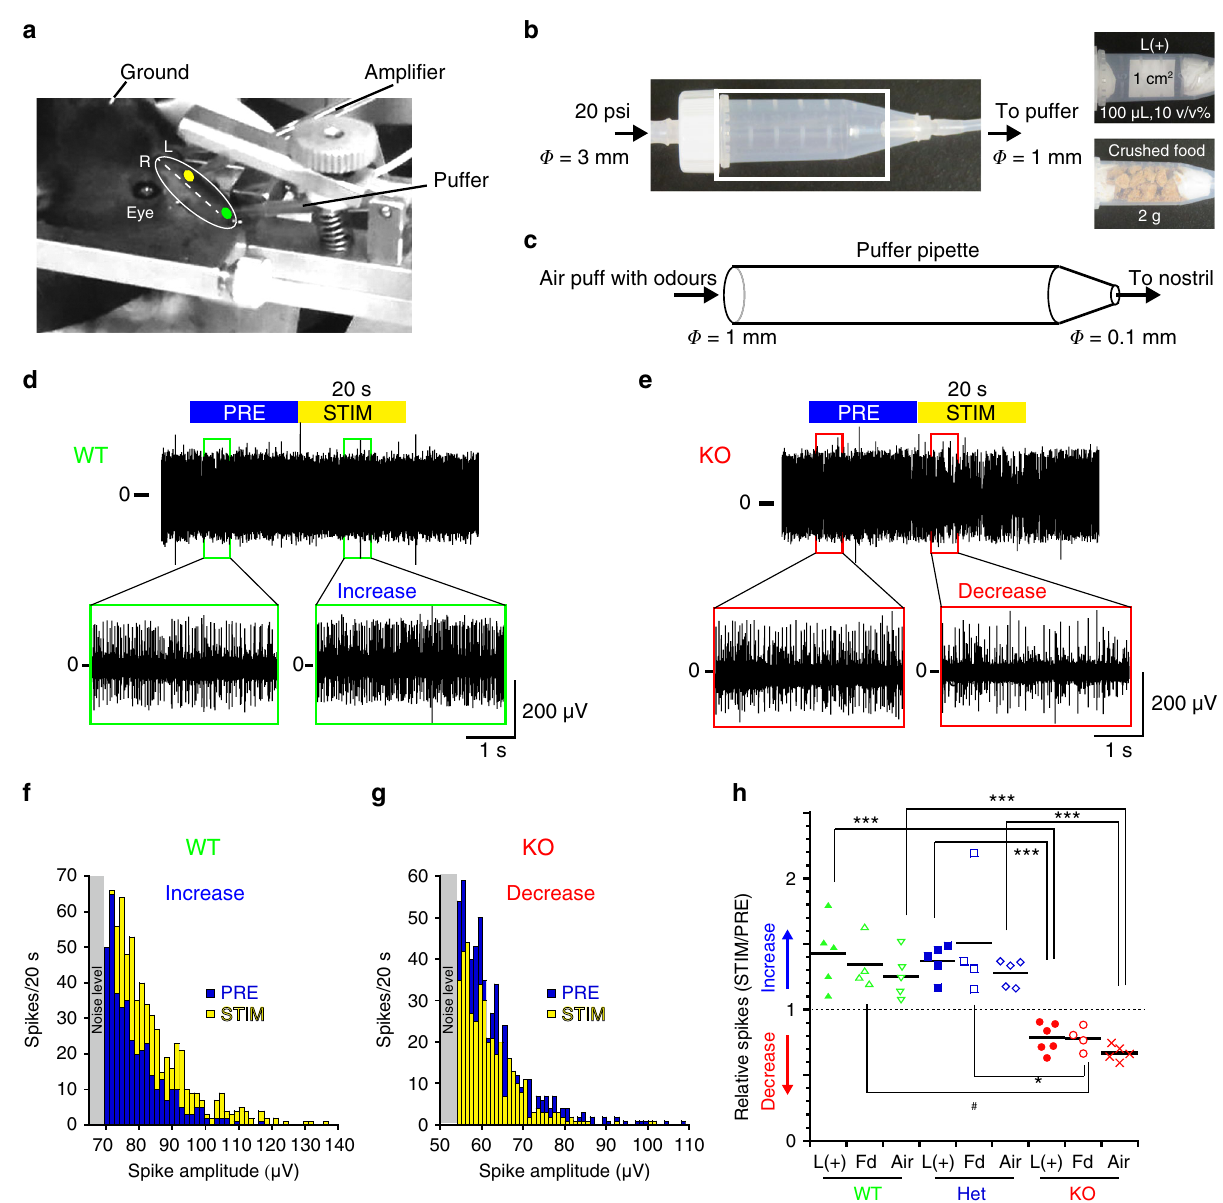
Fig. 7 OMP-KO nerves show rapid adaptation in response to repetitive stimulation. a Experimental setup of an in vivo multiunit recording from the nerve layer of the olfactory epithelium using a recording pipette inserted through a hole in the left nasal bone (a yellow dot). Odours were applied through a puffer pipette inserted into the left nostril (a green dot). b A 5-mL plastic tube containing scented fi lter paper or food as an odour application chamber was interconnected between a pressure pump and a puffer. c An approximately 0.2-psi air puff was applied from the puffer pipette into the nostril. Repetitive air puffs with 100-ms durations followed by 300-ms intervals at 20 psi were applied for 20 s. ϕ : diameters. d Multiunit responses from the nerve bundle layer of WT mice show sustained increases in fi ring during stimulation. e Multiunit responses from the nerve bundle layer of KO mice show a decrease during stimulation. f , g Representative histograms of spike amplitudes before (PRE) and during (STIM) odour-puff stimulation for 20 s in ( f ) WT mice and ( g ) KO mice. h Relative changes in the collective fi ring frequencies during nasal air-puff stimulation with L( + ) or food (Fd) or without odours (Air) to the resting frequencies (PRE) in ( h ) WT, Het and KO mice. Means: black bars. * P < 0.05; ** P < 0.01; *** P < 0.001. Statistics: h one-way ANOVA and the post hoc Bonferroni multiple-comparison test. L( + ); F (3, 13) = 23.06, P < 0.001 and P WT vs Het > 0.999, P WT vs KO = 0.0001, P Het vs KO = 0.0003. n = 5, 5 and 6 for WT, Het and KO. Food; F (3, 9) = 6.602, P = 0.017 and P WT vs Het > 0.999, P WT vs KO = 0.076 and P Het vs KO = 0.021. # means P WT vs KO = 0.045 in the